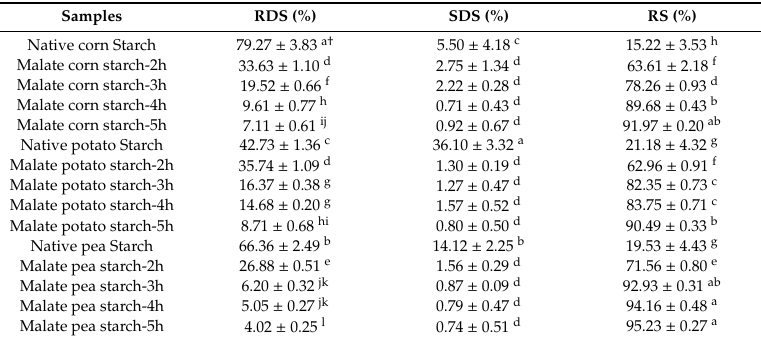
Figure 5. Thermal gravimetric analysis and derivative thermogravimetric analysis (TG / DTG) image of malate starch samples: ( A 1 ) Corn starch TG, ( A 2 ) Corn starch DTG, ( B 1 ) Potato starch TG, ( B 2 ) Potato starch DTG, ( C 1 ) Pea starch TG, ( C 2 ) Pea starch DTG. Table 1. Nutritional fractions of native and malate